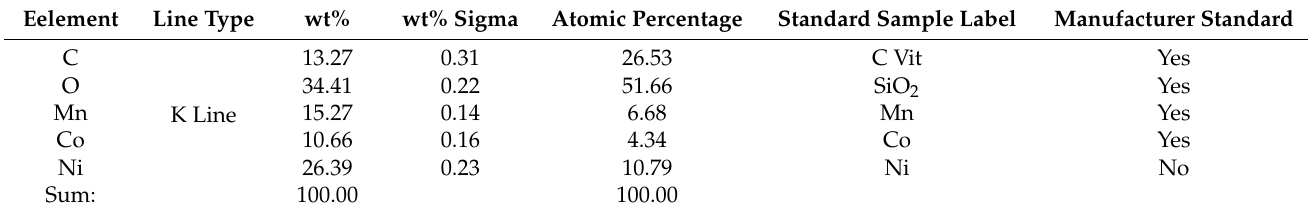
Table 1. The compositional raio of NCM523 cathode material.